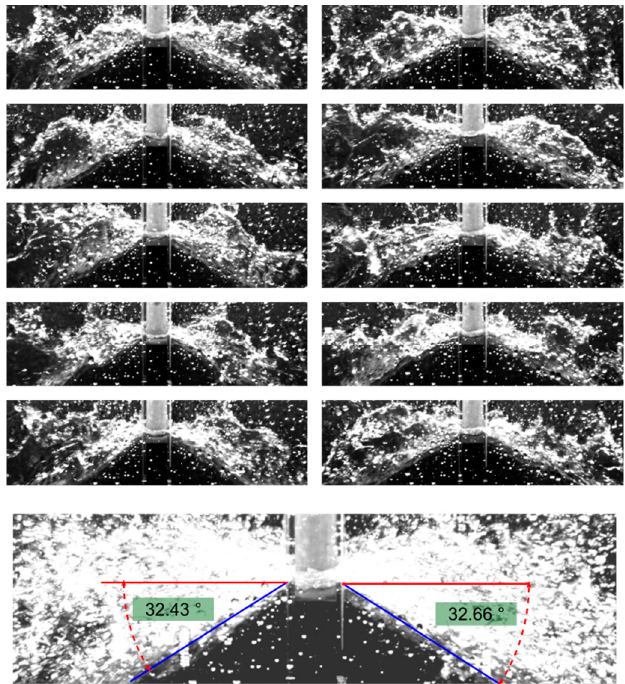
Figure 6. The top panels show photographs of water jets discharged (ejected) from the type A NIP taken at 0.5 s intervals. The bottom panel shows the superposition of the ten photographs above it and also shows the angles formed between the jets inferior contour (blue) and the line perpendicular to the ports (red).